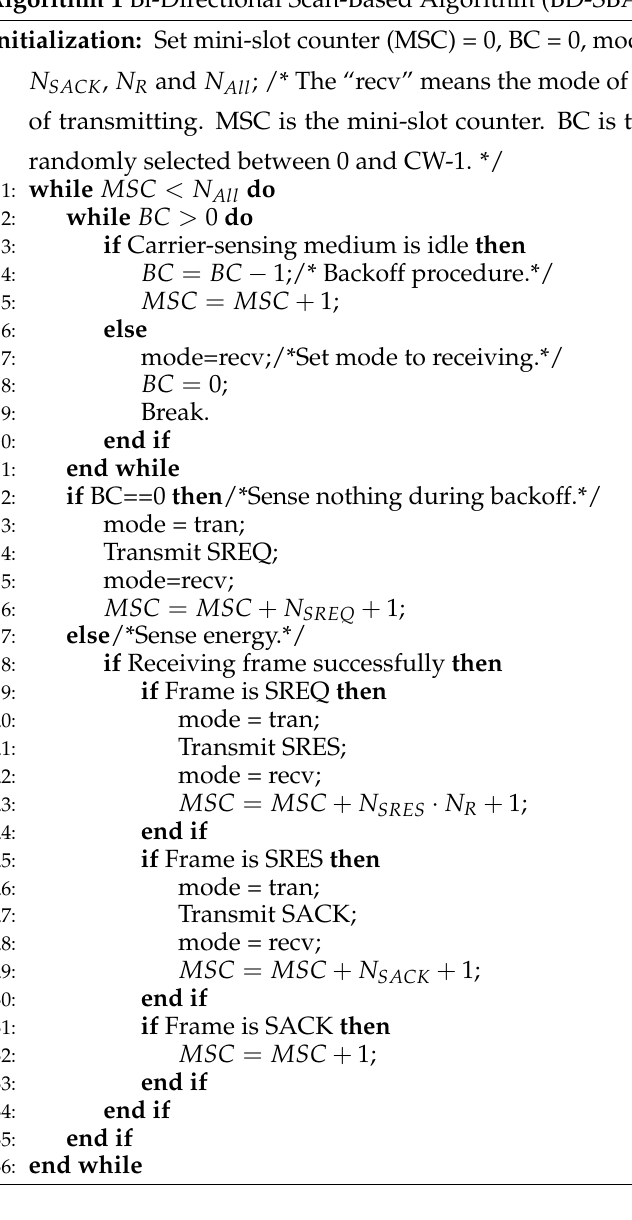
Algorithm 1 Bi-Directional Scan-Based Algorithm (BD-SBA)